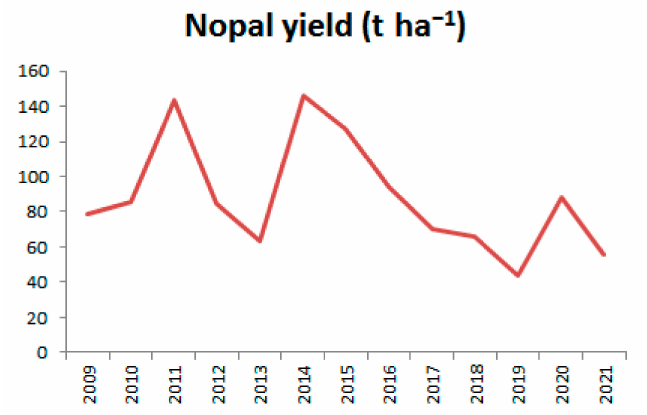
Figure 12. Vegetable Nopal yields